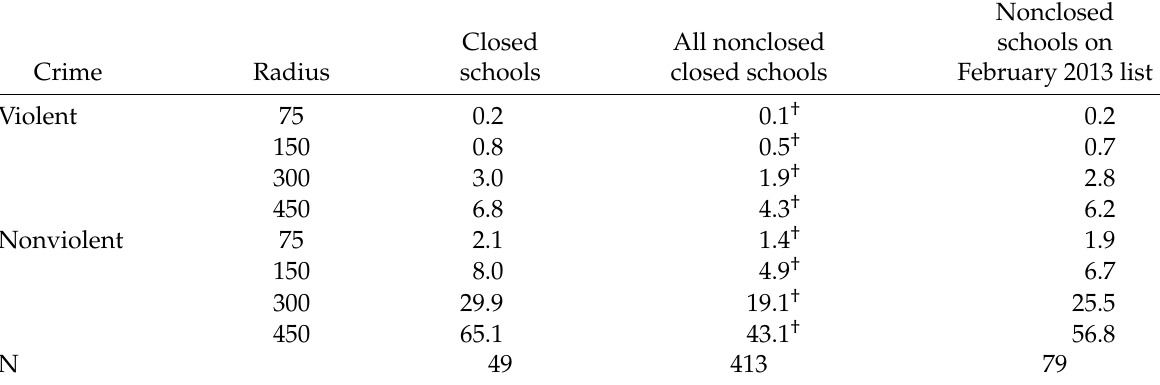
Table 2: Mean crime counts by school-buffer radius before June